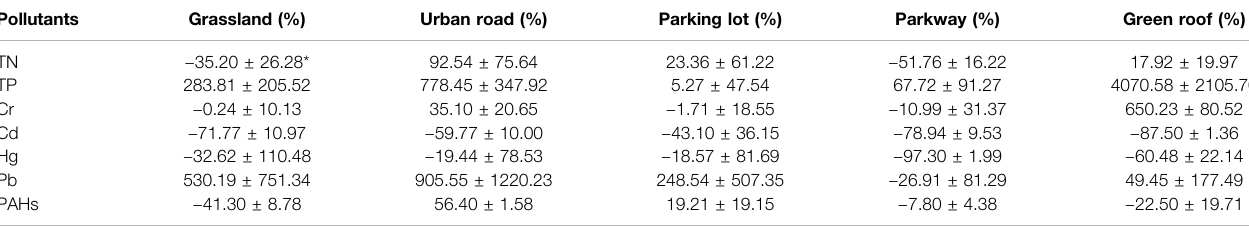
TABLE 4 | The rates of decrease in the seven pollutants in stormwater runoff on the underlying surfaces.